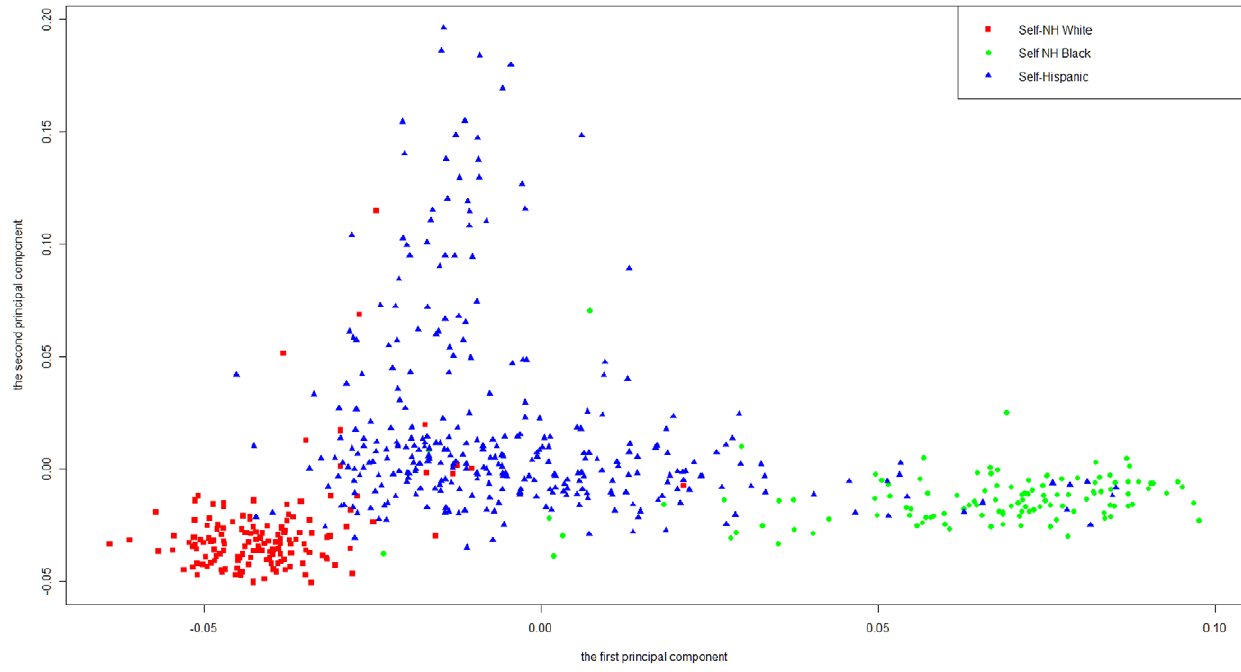
Figure 1. Scatter-plot of the first and second principal components. Scatter-plot of the first and second principal components calculated from the genotypes of 213 AIMs. The first principal component scores showed good separation between the self-reported non-Hispanic white and self-reported non-Hispanic black groups, while the principal component scores of self-reported Hispanic group were in-between.